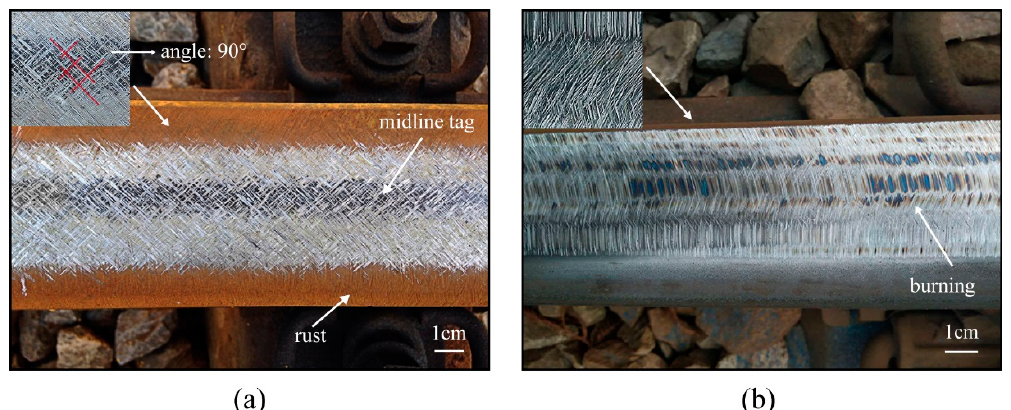
Figure 9. Rail surface topography, ( a ) after passive grinding, ( b ) after active grinding. The unique grinding morphology of passive grinding is related to the grinding be- havior of the grinding wheel in the passive grinding process. Selecting an abrasive on the passive grinding wheel, and its motion trajectory is shown in Figure 10a. It can be found that the trajectory line of passive grinding is spiral. When numerous spiral lines produced by the grinding wheels in both directions overlap each other, the passive grinding marks on the rail surface form the decussation, as shown in Figure 10b. It results in the production of two vertical grinding marks in two directions and forms the decussate surface topography.